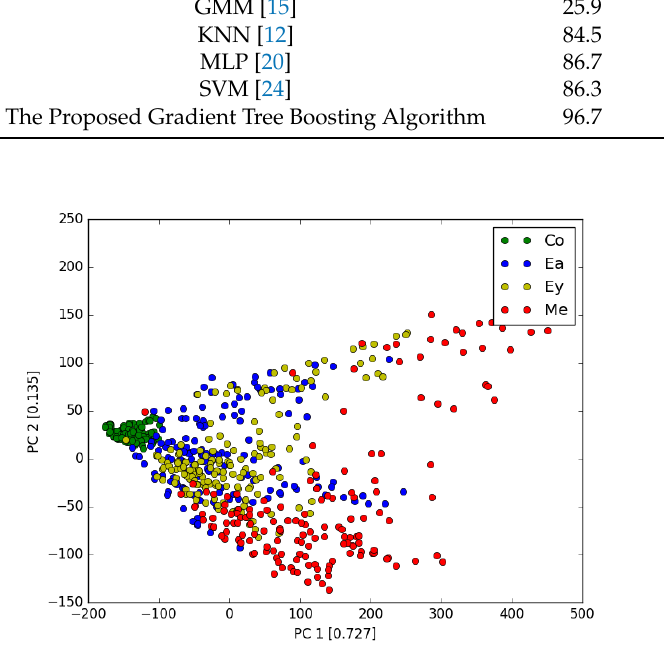
Figure 4. 2-dimensional PCA plot of 4